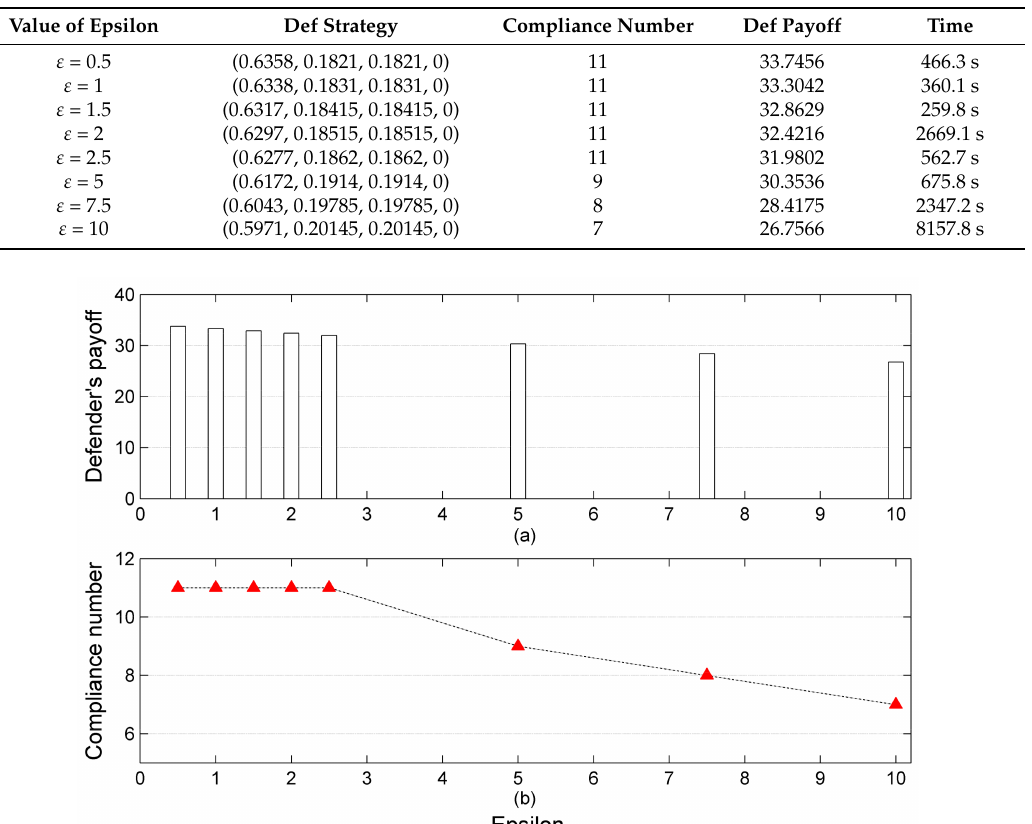
Table 6. Results computed by COBRA under different rationality levels of attackers (the notation of time represents the running time of the solver and the notation of s in this table denotes seconds).